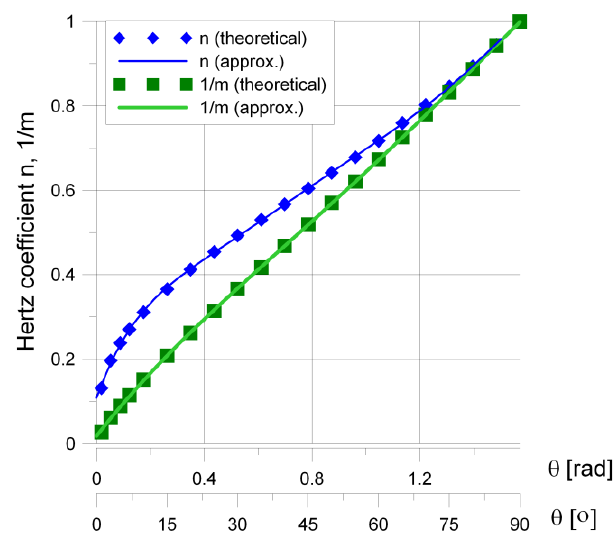
Figure 7. Distribution of m and n parameters in the function of angle θ.